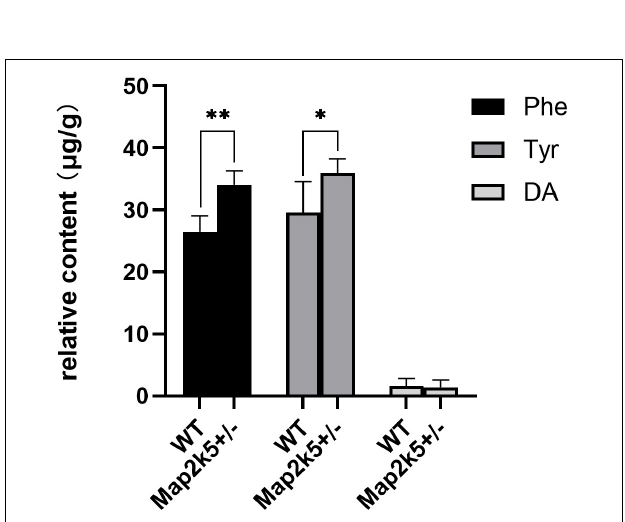
FIGURE 6 | The values of neurochemicals in dopamine synthesis pathway are represented. Phe and Tyr are accumulated significantly in Map2k5 + / − mutant mice ( P = 0.001, 0.033, respectively, n = 5). Results are plotted as mean with SEM. Bars represent means with SEM. * P < 0.05, ** P <